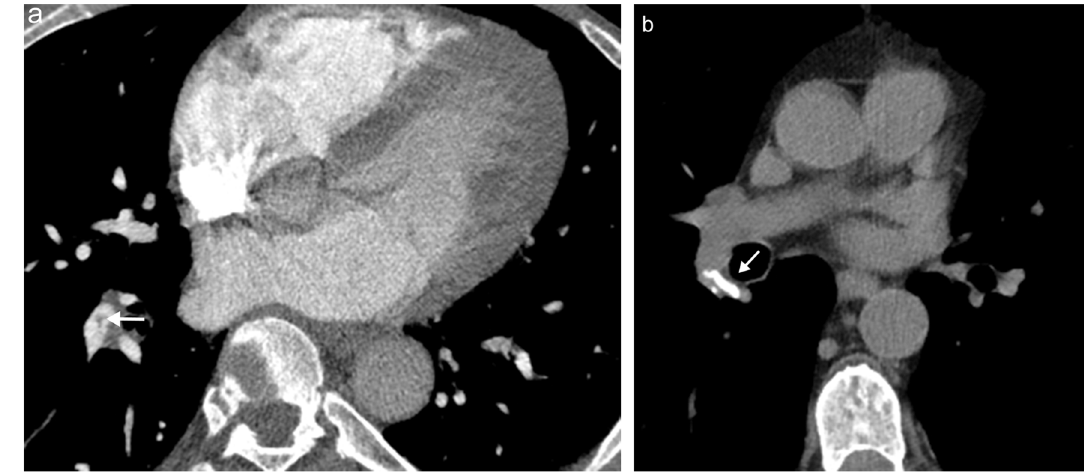
Fig. 10 Two patients with chronic pulmonary emboli. a Axial contrast- enhanced CT image shows a web-like filling defect within a segmental right lower lobe pulmonary artery consistent with chronic pulmonary